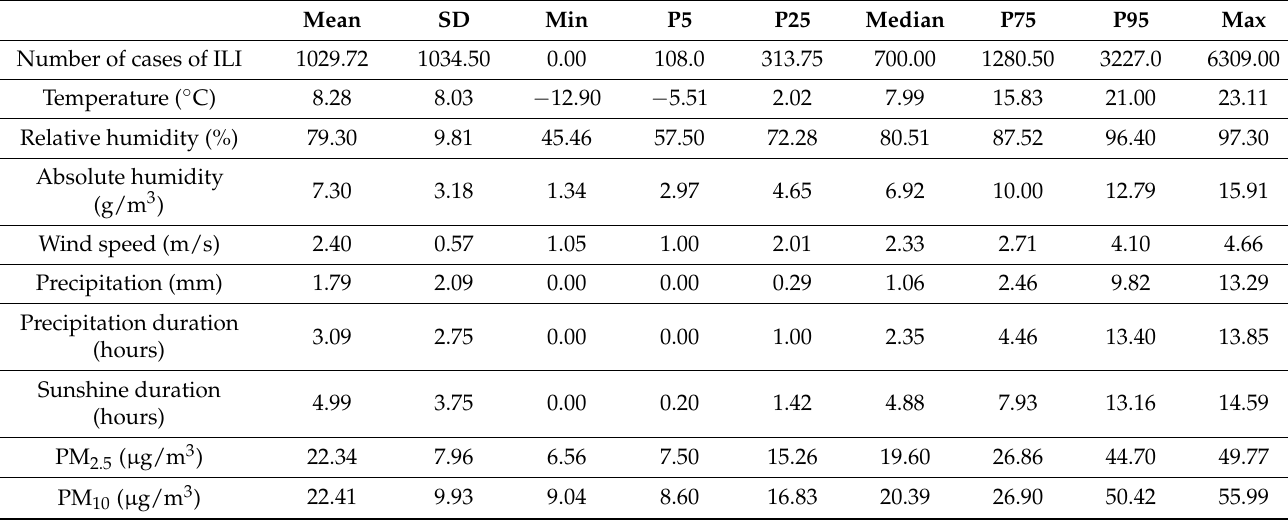
Table 1. Weekly meteorological variables, air pollutants and the incidence of influenza-like illness in Bialystok, January 2013–December